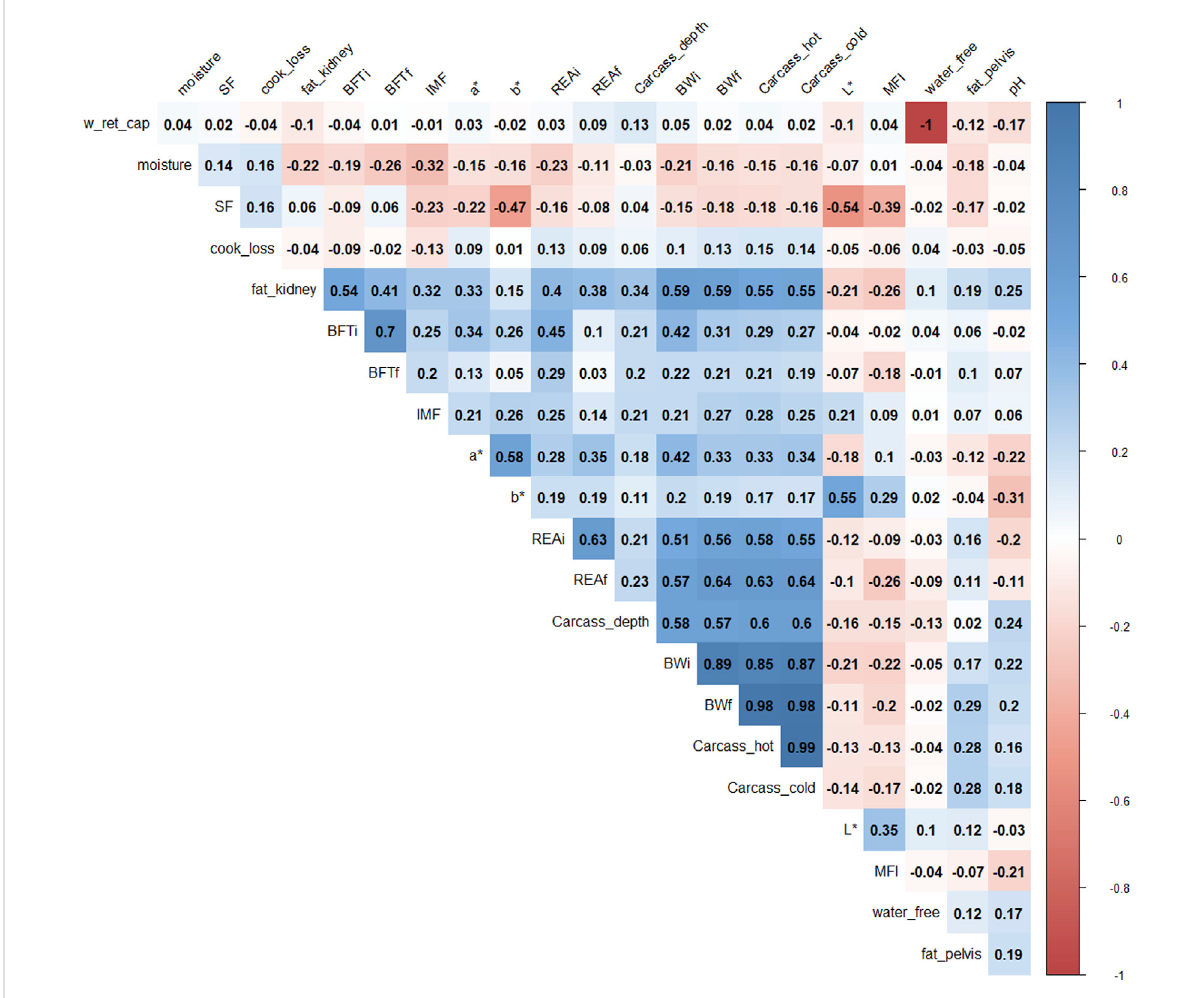
Correlation plot of 22 phenotypes. The degree of shading and the value reported correspond to the correlations among the traits. BWi: pre- feedlot body weight; REAi: initial ribeye area by ultrasonography; REAf: fi nal ribeye area on steak; BFTi: initial backfat thickness by ultrasonography; BFTf: fi nal backfat thickness by carcass; fat_pelvis: pelvis fat content at carcass; fat_kidney: kidney fat content; carcass_hot: hot carcass weight; carcass_cold: cold carcass weight; carcass_depth: carcass depth; pH: pH at 24 h; water_free: free water; w_ret_cap: water holding capacity; moisture: meat moisture; SF: shear-force; MFI: mio fi brilar fragmentation index; L*, a*, b*: color parameters; and IMF: intramuscular